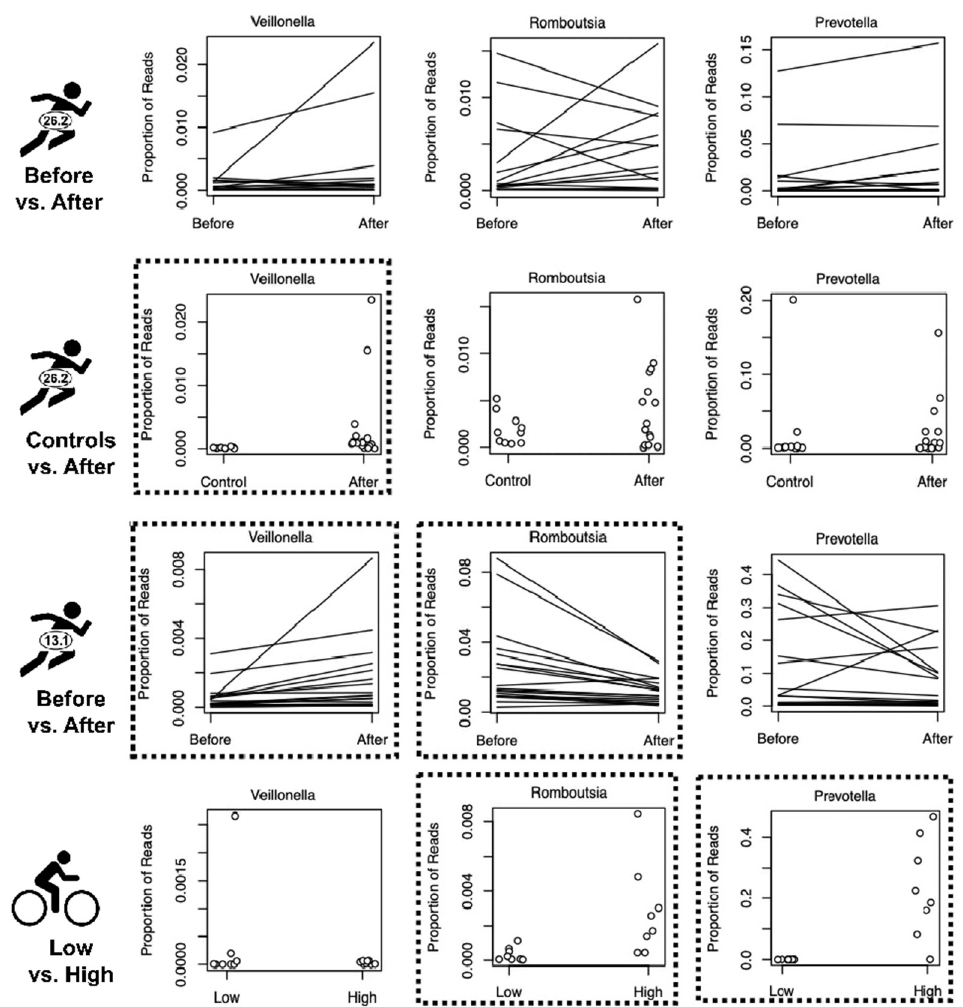
Figure 3. Relative abundance for three selected bacterial genera comparing Boston Marathoners before vs. after (1st row), sedentary controls vs. athletes after (2nd row), Chongqing Half-Marathoners before vs. after (3rd row), and competitive cyclists in the low-volume vs. high-volume-training groups (4th row). Lines connect paired samples of the same individual (before vs. after), whereas points compare samples taken from different individuals (controls vs. athletes or low- vs. high-training groups). Significant differences between treatment groups are indicated with boxes with dotted borders.